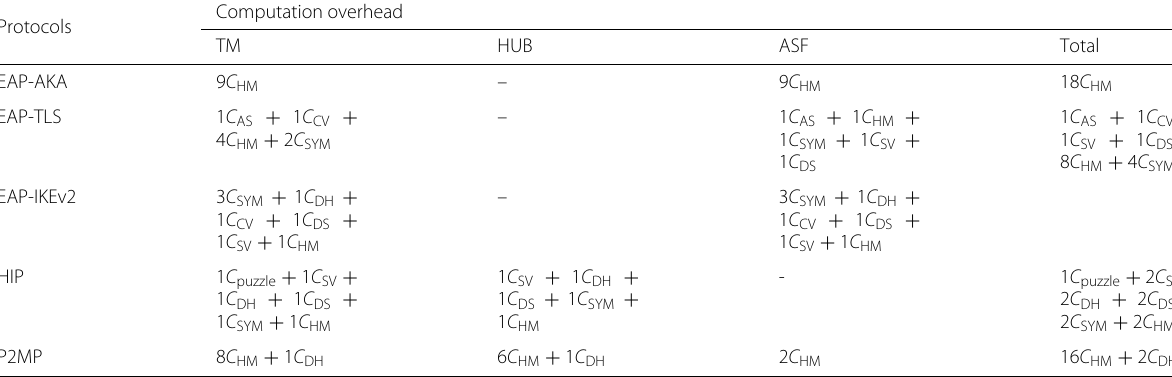
Table 6 Comparison of protocols by computation overhead